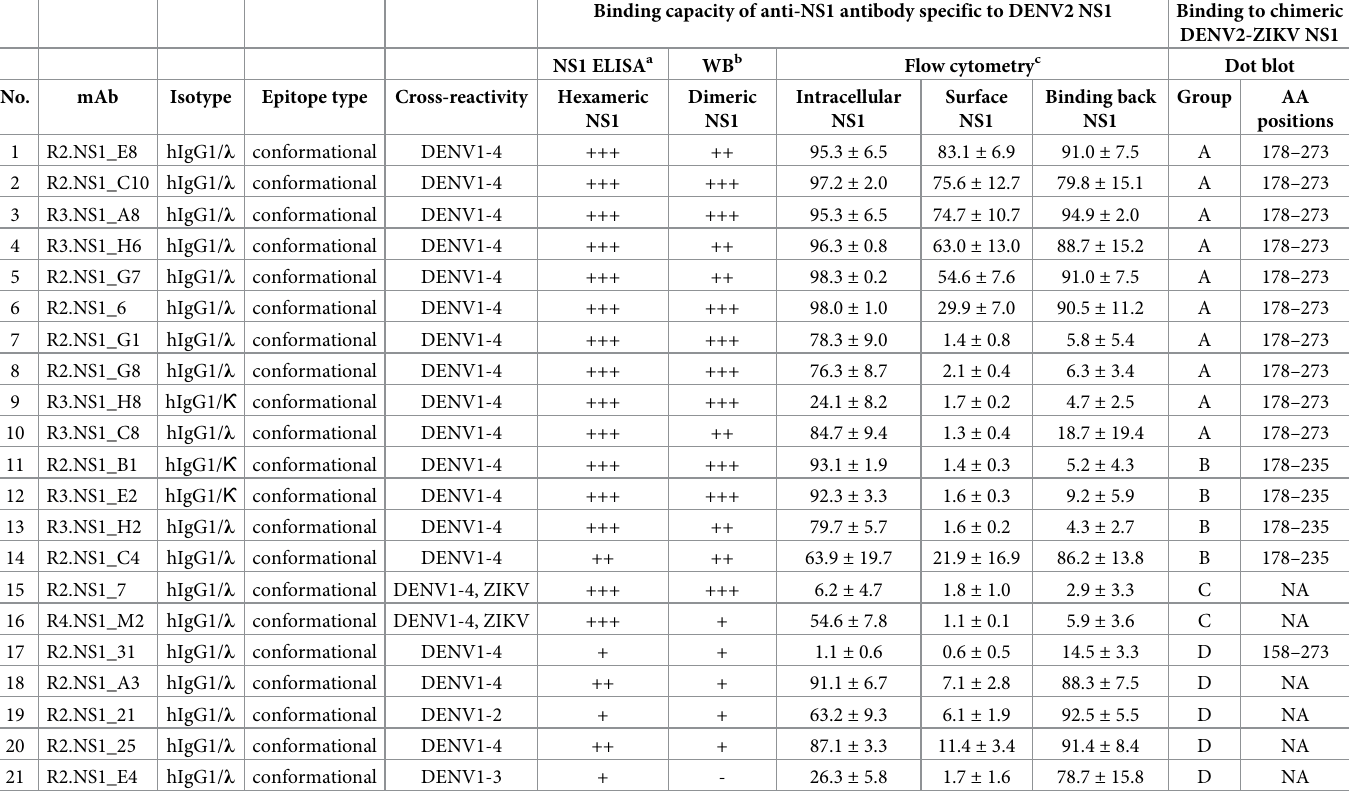
Table 2. Characterizations of human anti-NS1 mAbs and their binding regions on DENV2 NS1.